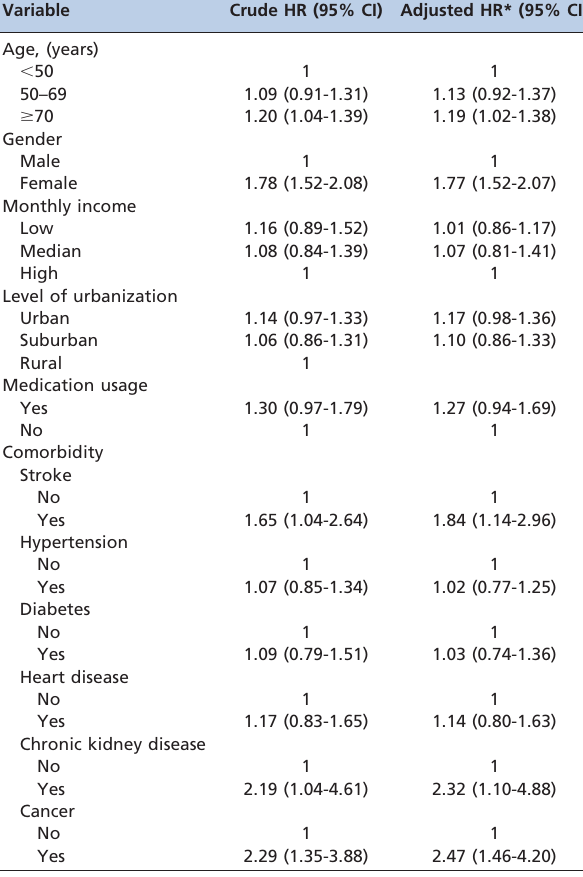
Table 3 - Multivariate analysis of factors related to the risk of depression among RA